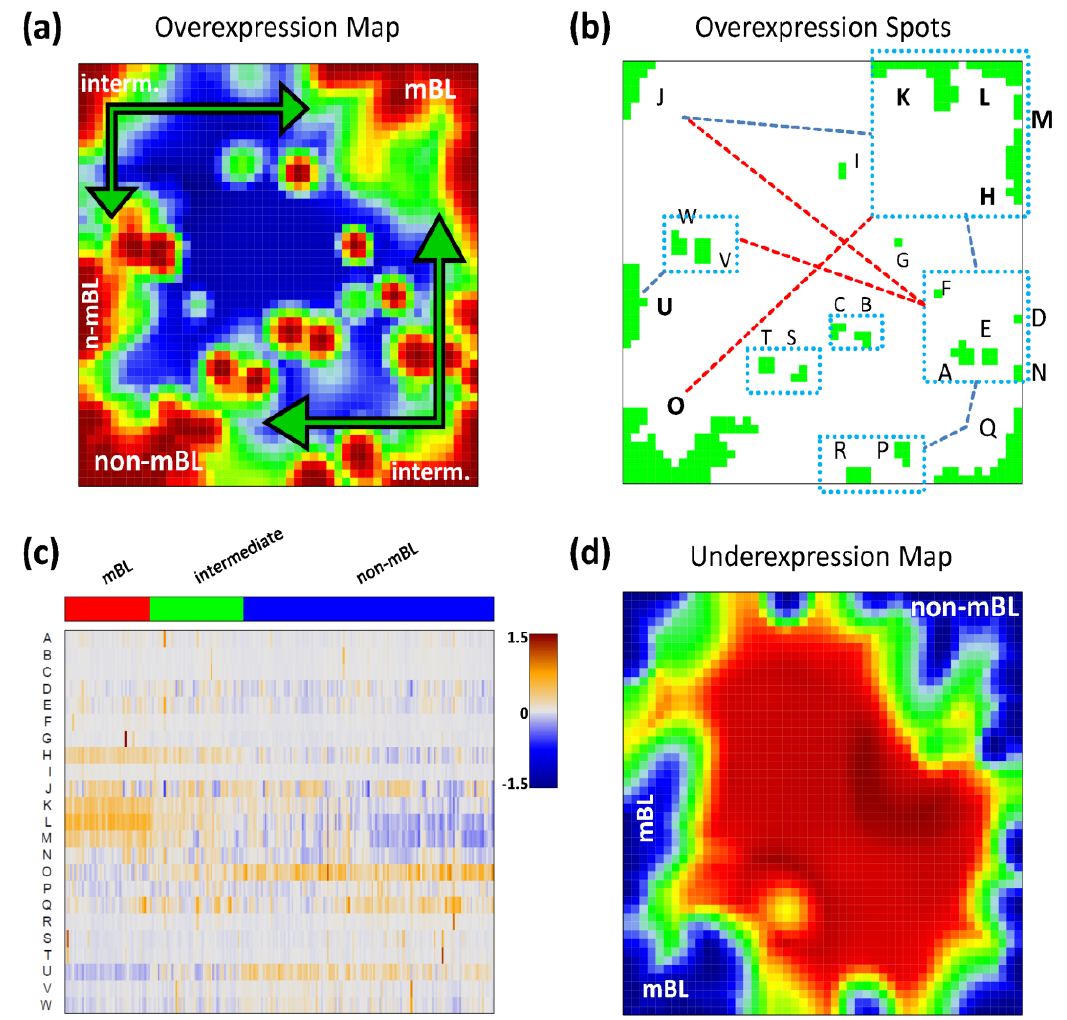
Figure 2. Spot module characteristics: ( a ) The over-expression summary map collects all over-expression spots observed in the individual portraits into one map. Subtypes frequently showing the respective spots are indicated. ( b ) The over-expression spot map defines the spots used for further analysis. Regions beyond the 98th-percentile threshold of metagene expression are selected. The spots are assigned by large capital letters. The blue rectangles include highly correlated spots ( r > 0.7). The blue and red dashed lines connect correlated (0.4 < r < 0.7) and anti-correlated ( r < (cid:237) 0.6) spots, respectively. ( c ) The overexpression heatmap shows the mean expression of the spots across all samples in the data set. The samples are sorted according to their subtype. ( d ) The under-expression summary map collects all under-expressed spots observed in the individual portraits. Note the antagonistic nature of mBL and non-mBL expression: spots over-expressed in mBL become under-expressed in non-mBL and vice versa (compare with panel